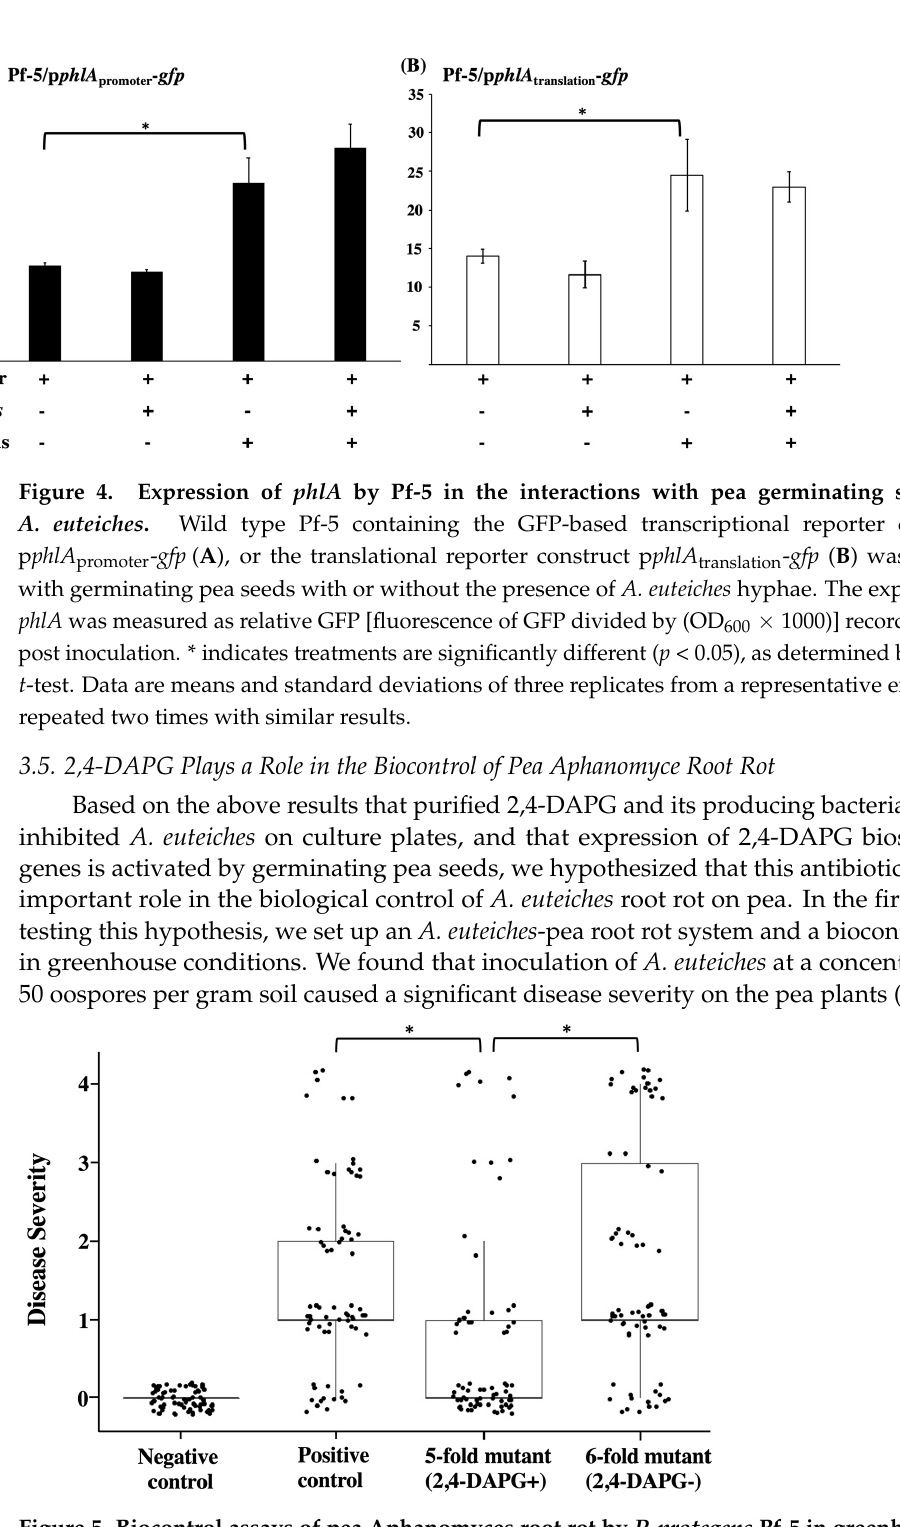
Figure 5. Biocontrol assays of pea Aphanomyces root rot by P. protegens Pf-5 in greenhouse. Pea seeds without inoculation served as negative control; pea seeds in positive control were planted in soil containing A. euteiches (50 oospores per gram soil) but not the Pf-5 strains. 5-fold mutant: ∆ pltA ∆ pcnC ∆ ofaA ∆ rzxB ∆ hcnB ; 6-fold mutant: ∆ pltA ∆ pcnC ∆ ofaA ∆ rzxB ∆ hcnB ∆ phlA . Disease severity was evaluated on a 0–4 disease level scale. Scatter plot shows combined data from two independent experiments each had six replicates (i.e., six growth pots) per treatment and each replicate included five to six pea plants. * indicates treatments are significant different ( p < 0.05), as determined by one-factor ANOVA